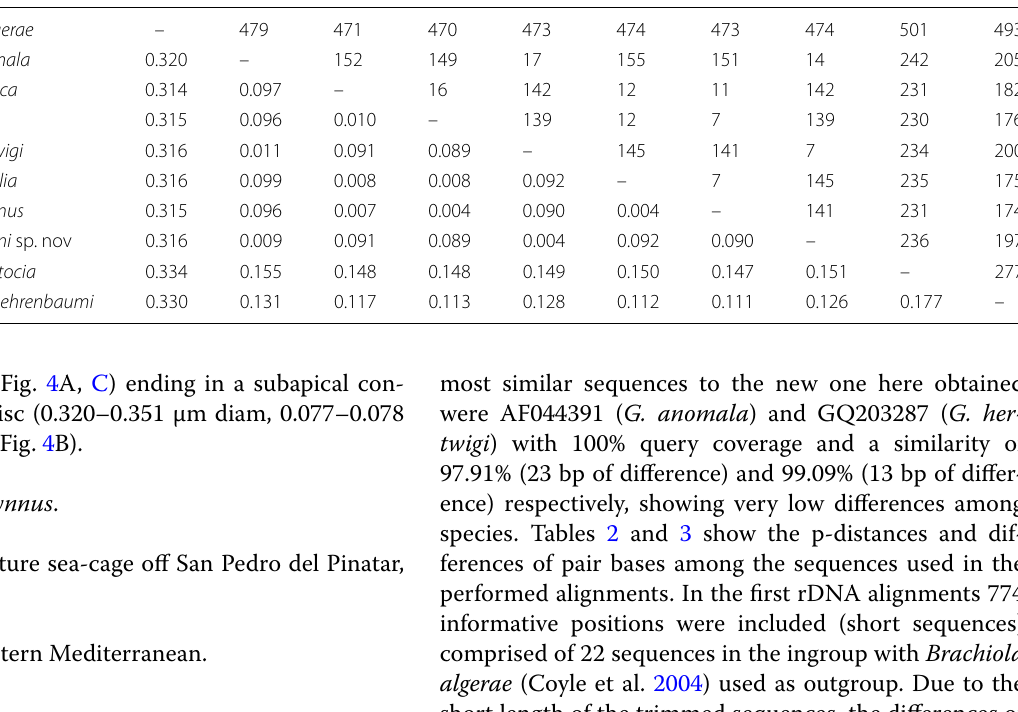
Table 3 Differences among representatives of the genera Brachiola , Glugea , Loma and Pleistophora for 16S rDNA sequences, pairwise nucleotide differences (above the diagonal) and p‑distances (below the diagonal) 1713 bp sequences